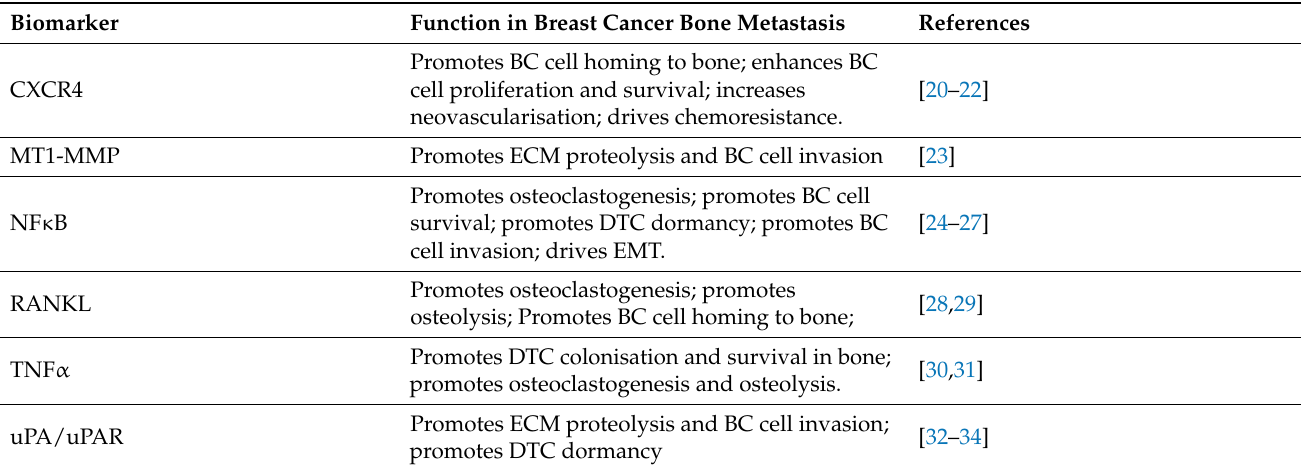
Table 1. Summary of biomarker function in breast cancer bone